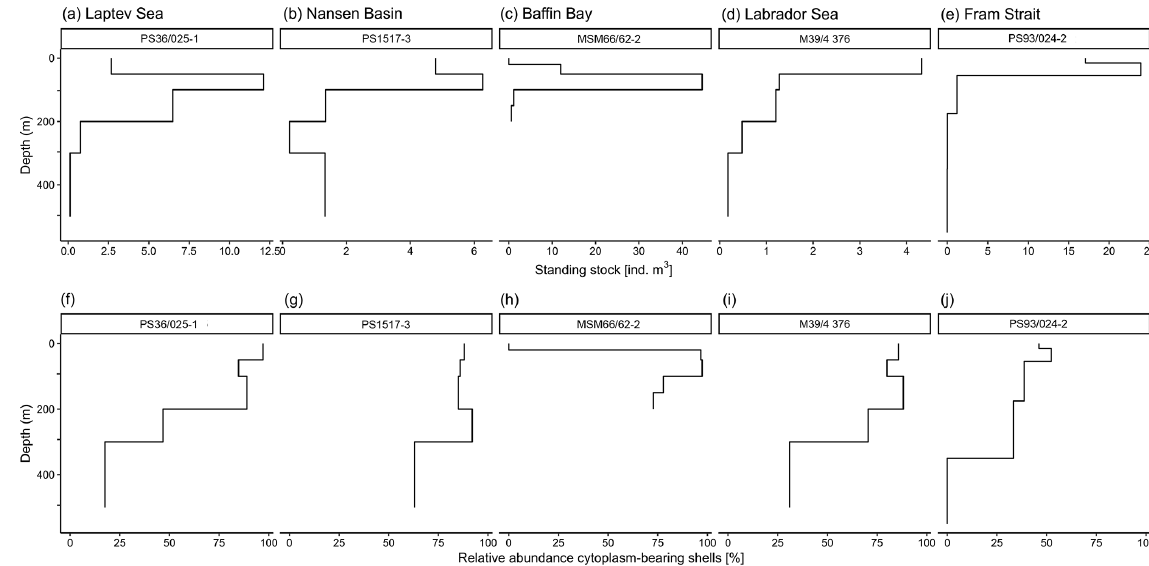
Figure A1. Example of vertical profiles of abundances of N. pachyderma at five different sampling locations from different parts of the Arctic Ocean. Panels (a) – (e) show absolute shell number concentration (ind.m − 3 ) of N. pachyderma and (f) – (j) relative abundance of cytoplasm-bearing shells of N. pachyderma